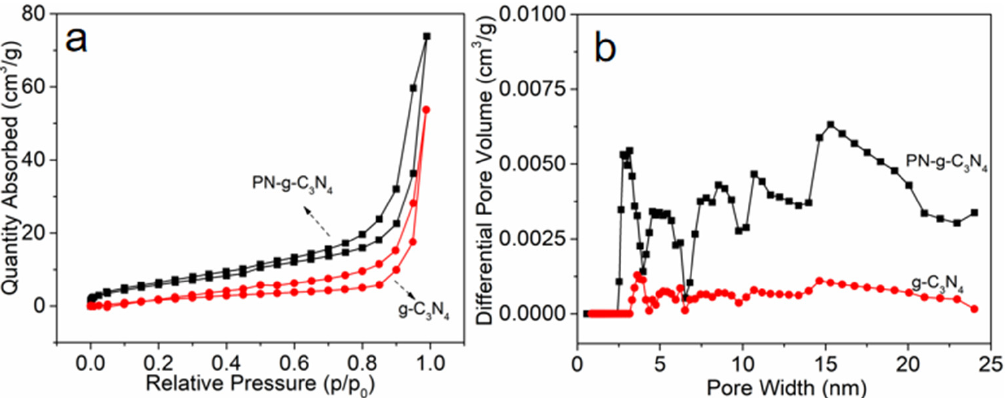
Figure 3. N 2 adsorption/desorption isotherms ( a ) and BJH pore size distribution of g-C 3 N 4 and PN-g-C 3 N 4 ( b ).